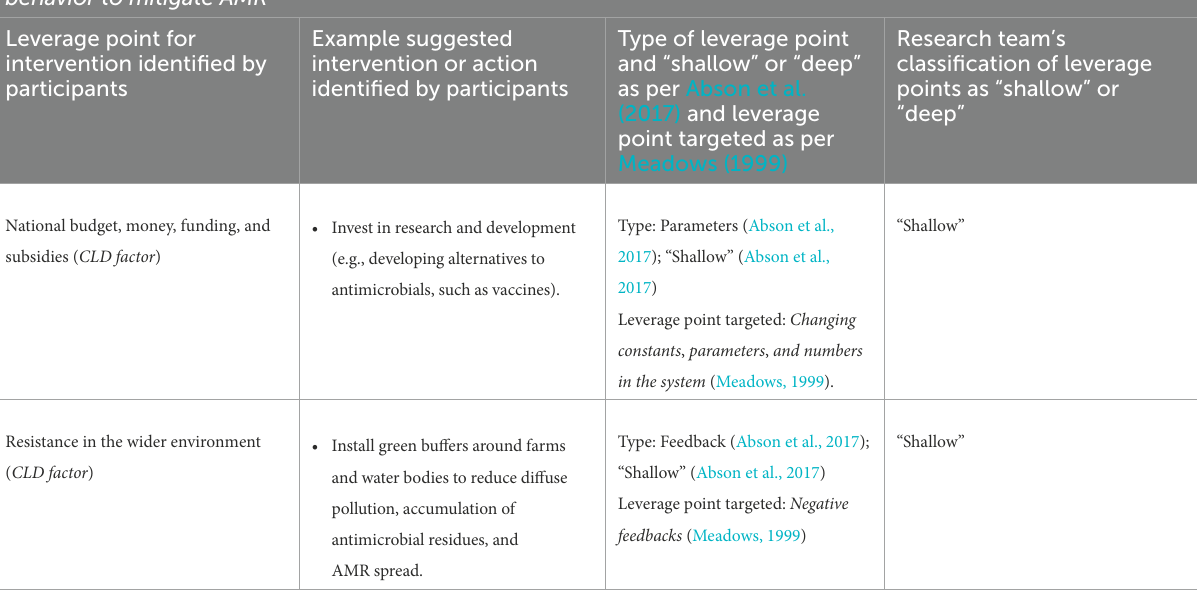
TABLE 3 Shallow leverage points and suggested associated